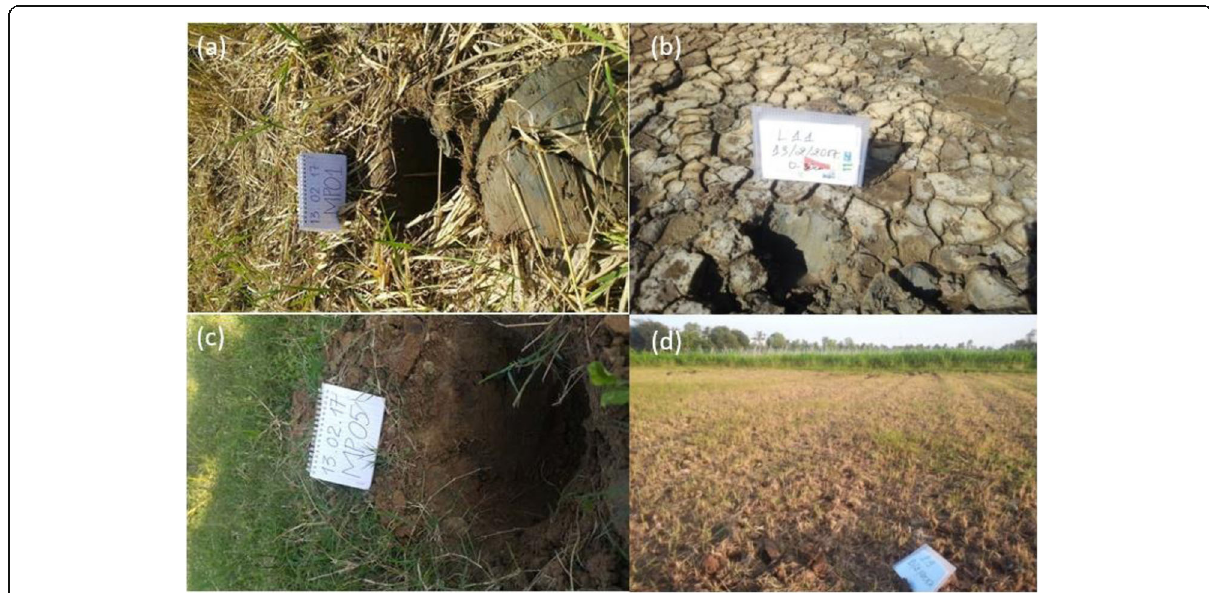
Fig. 4 Four photos show soil samples taken at different soil types on 13 February 2017 under sunshine condition. Detail characteristics of each point are described as follows: a MP01 is paddy rice field after harvest with 6 m elevation; , b L11 is of former use for aquaculture for shrimp at 5 m elevation; c MP05 is land use to grow banana surrounded by paddy field at 5 m elevation; and d P9 is paddy rice field at harvest time at 3 m elevation